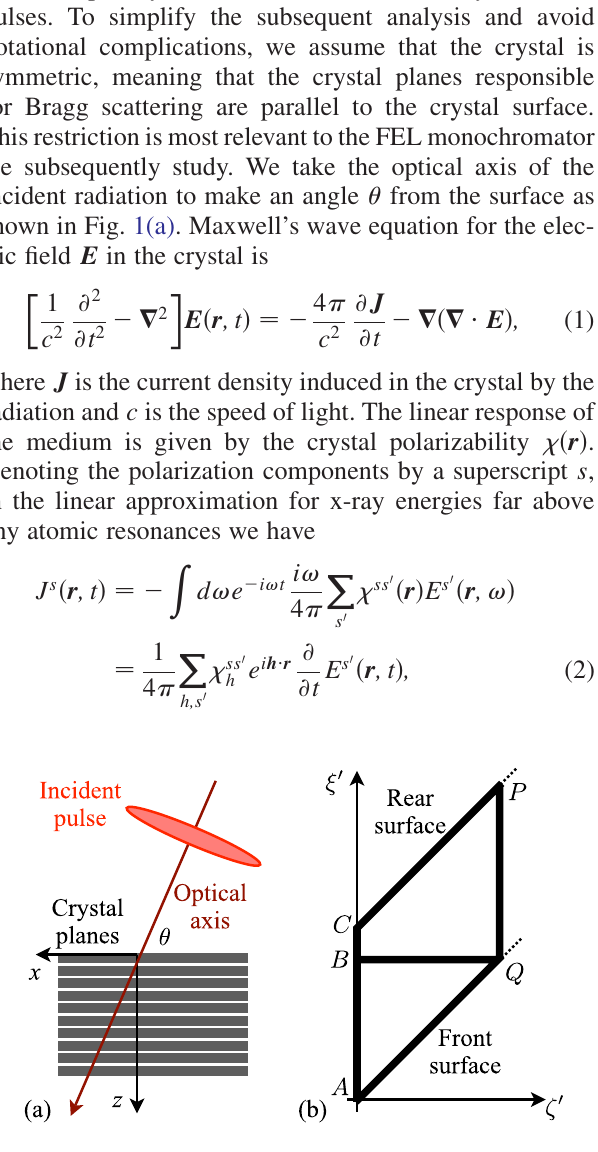
FIG. 1. Geometry of Bragg scattering. Part (a) shows that the incident pulse travels along the optical axis that makes an angle (cid:2) with respect to the crystal surface. Part (b) plots the geometry in the characteristic coordinate plane (cid:7) 0 - (cid:8) 0 , with the crystal entrance and rear surfaces located at (cid:7) 0 ¼ (cid:8) 0 (the line AQ ) and (cid:7) 0 ¼ (cid:8) 0 (cid:2) d (the line CP ), respectively. We also include the integration contours ABQ and ACPQ that are used to obtain the solution for the reflected and transmitted